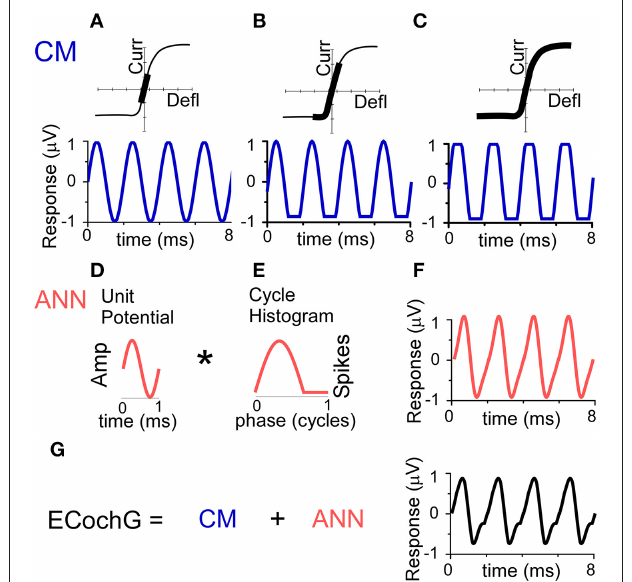
FIGURE 2 | Conceptual basis of the model for the ongoing part of the ECochG response to low frequency tones. (A–C) The CM. To a low stimulus intensity (A) , the hair cell stereociliary motion and channel openings operate symmetrically within the input-output function (top, black bar), producing a sinusoidal CM response (bottom). (B) With increasing stimulus intensity, asymmetric saturation can occur if the operating point (average state of the channels at rest) is displaced from the center of the function (top), producing a CM saturated only to one side of motion, in this case the trough of the CM (bottom). (C) With a high stimulus intensity, symmetric saturation occurs with maximal deflection at both ends of the oscillation (top), creating a CM with saturation to both the peak and trough. (D–F) The ANN is created by the convolution (*) of the unit potential (D) and the population cycle histogram (E) . The unit potential is the shape of a single action potential at the round window, and the cycle histogram is the sum of action potential firing in the population of the across all responding nerve fibers. Because the cycle histogram is derived by folding the periods in the post-stimulus time histogram, this process is identical to that previously modeled to produce the CAP (see text for references). The non-linearities inherent in this process will always create a distorted version of the cyclic response (F). (G) The ongoing ECochG represents the sum of the CM and ANN.